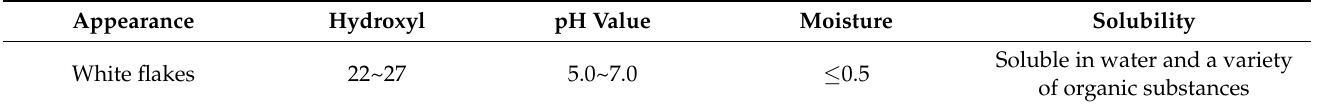
Table 8. Technical indicators of water-reducing agent.